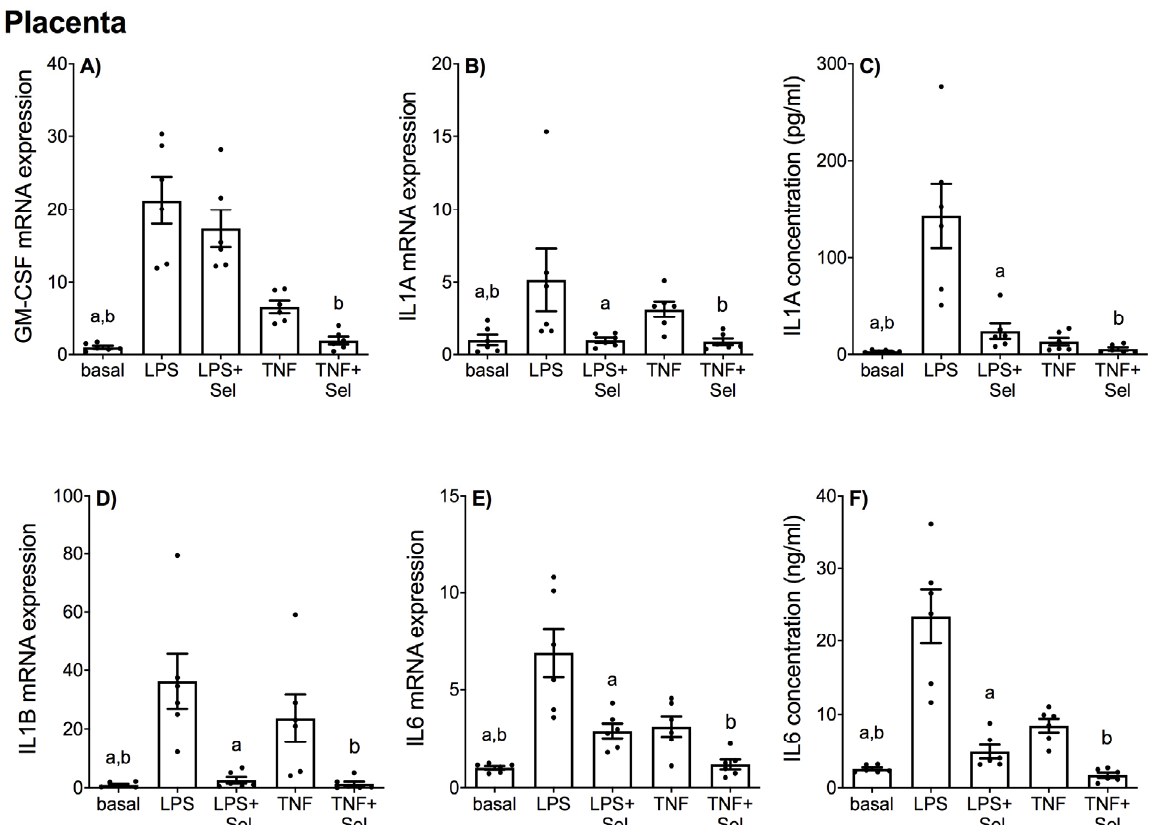
Figure 1. Effect of selenium on pro-inflammatory cytokine expression in human placenta. Human placenta was incubated with or without 10 µM sodium selenite (Sel) for 1 h and then stimulated with 10 µg/mL LPS or 10 ng/mL TNF- α for a further 20 h ( n = 6 patients). ( A , B , D , E ) GM-CSF, IL1-A, IL1-B and IL6 mRNA expression were analysed by RT-qPCR and fold change was calculated relative to basal expression. ( C , F ) The concentration of IL1-A and IL6 in the conditioned media was assayed by ELISA. For all graphs, individual data points represent six independent experiments and are displayed as mean ± SEM. a p ≤ 0.05 vs. LPS, b p ≤ 0.05 vs. TNF- α ; repeated measures one-way ANOVA.